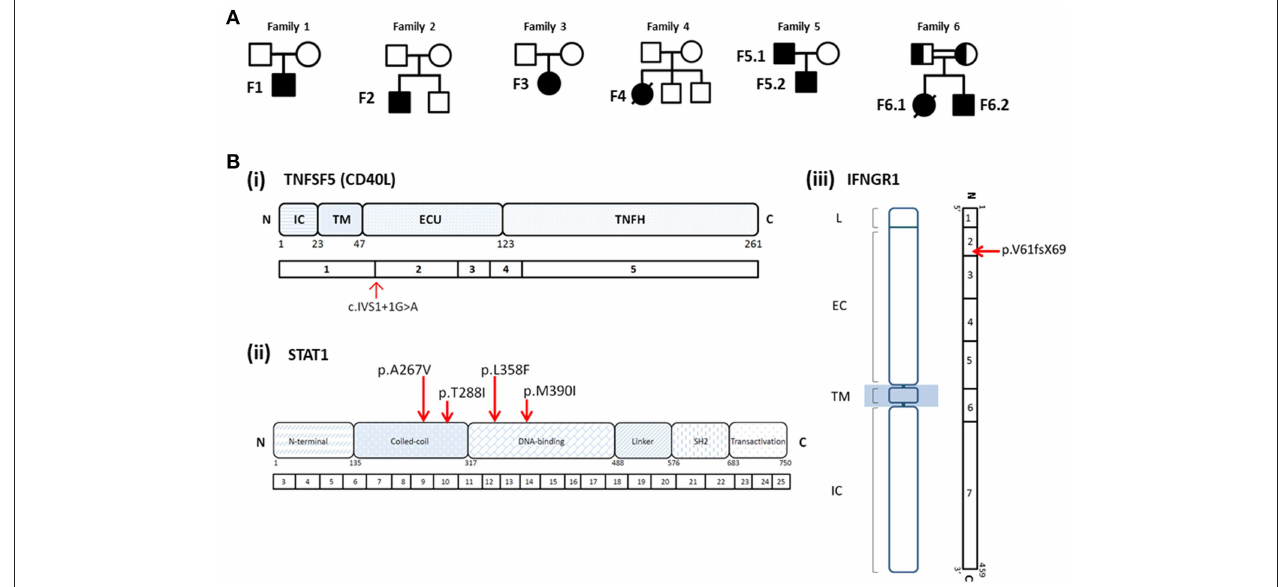
FIGURE 2 | (A) Pedigrees of Families 1–6. (B) Mutations identified in patients with T. marneffei infections. (i) Splice site mutation in TNFSF5 ( CD40L ) in Patient F1; (ii) heterozygous missense mutations in STAT1 identified in Patients F2 (p.A267V), F3 (p.T288I), F4 (p.L358F), F5.1, and F5.2 (p.M390I); (iii) homozygous mutation in IFNGR1 identified in Patient F6.2 (p.V61fsX69) and his deceased elder sister (F6.1). Both parents were found to be heterozygous carriers of the